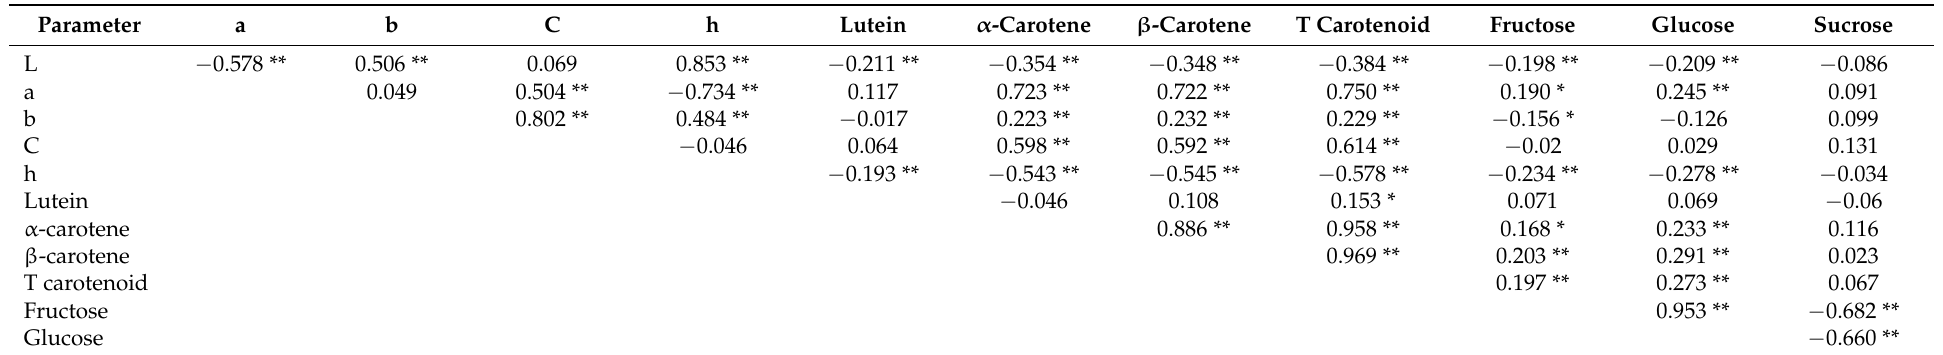
Table 7. Correlation analysis among the color attributes, carotenoids, and free sugars in carrots ( n =